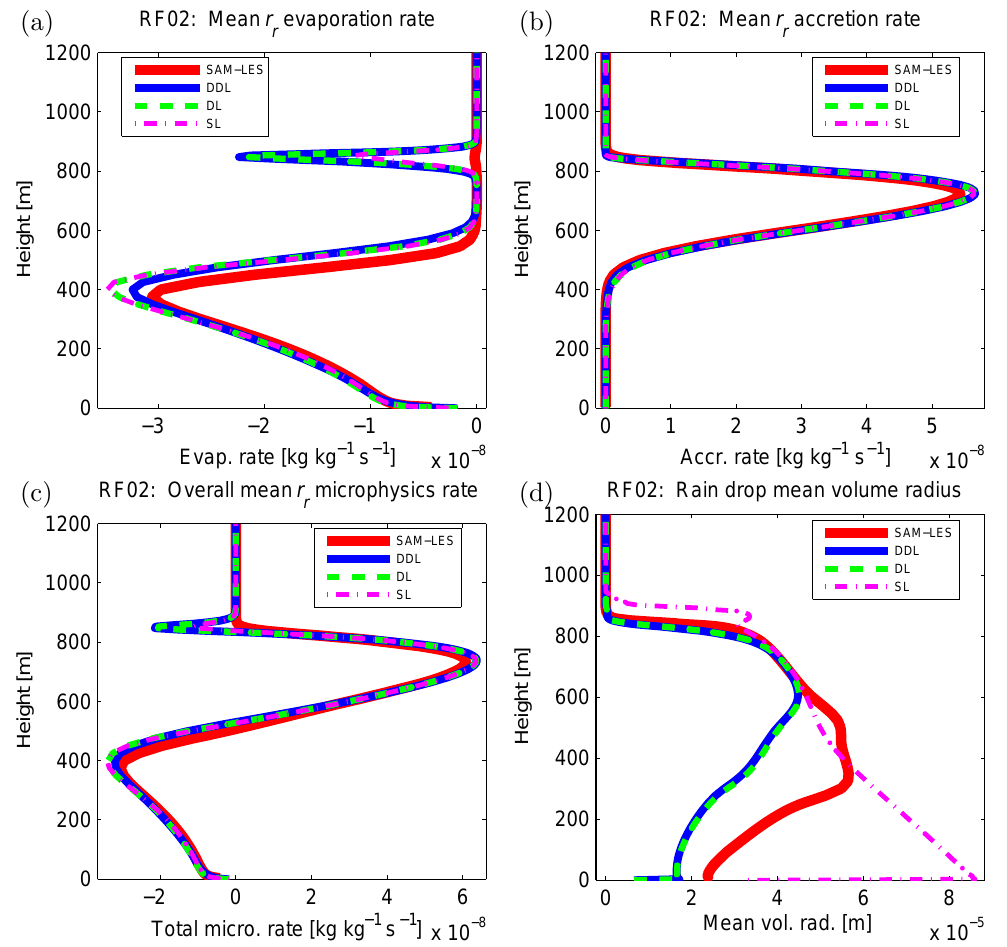
Figure 8. Profiles of mean microphysics process rates in the DYCOMS-II RF02 drizzling stratocumulus case time-averaged over the last hour of the simulation (minutes 300 through 360). The SAM LES results are red solid lines, the DDL results are blue solid lines, the DL results are green dashed lines, and the SL results are magenta dashed-dotted lines. (a) The mean evaporation rate of r r . (b) The mean accretion rate of r r . (c) The overall mean microphysics tendency for r r . (d) The mean volume radius of rain drops. All hydrometeor PDF shapes provide a good fit to SAM